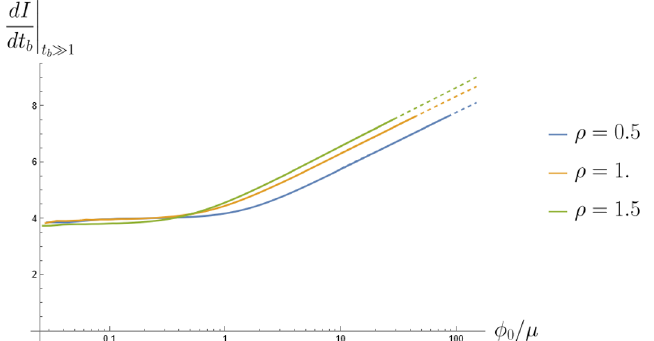
Figure 27 . Asymptotic value of complexity at late time as function of the scalar source, for z h . The dashed lines are extrapolations following the law dI